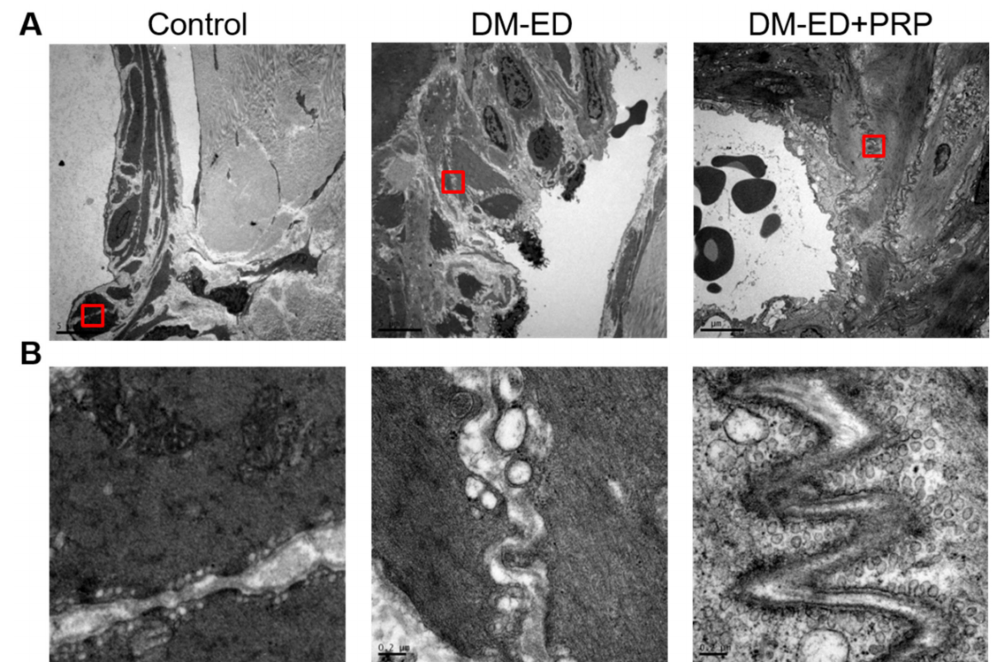
Figure 8. Transmission electron microscopy (TEM) of the caveolae in 2500 × ( A ) and 40,000 × ( B ) magnifications of the red-coloured demarcated area from ( A ). DM-ED = streptozotocin (STZ)- induced diabetes mellitus (DM) with erectile dysfunction (ED) and treated with saline; DM-ED + PRP, STZ-induced DM with ED and treated with platelet-rich-plasma. (Scale: ( A ): 5 µ m; ( B ): 0.2 µ m).